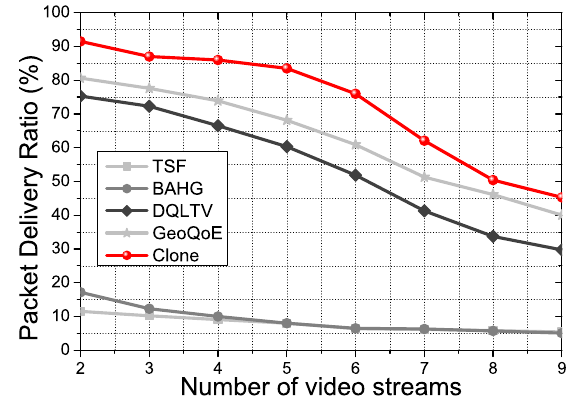
Figure 15. PDR for the number of video